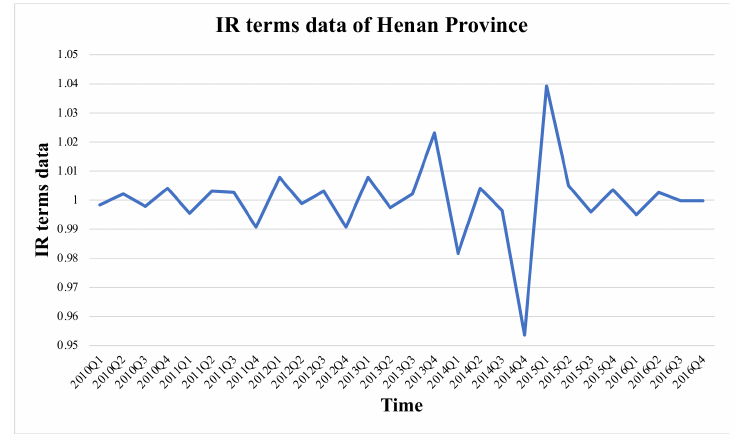
Figure 17. IR terms data of Henan Province. Table 10. Mutability trait test results for